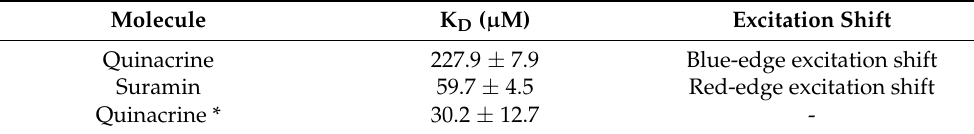
Table 2. Summary of the SARS-CoV-2 3CL pro in the complexes with quinacrine and